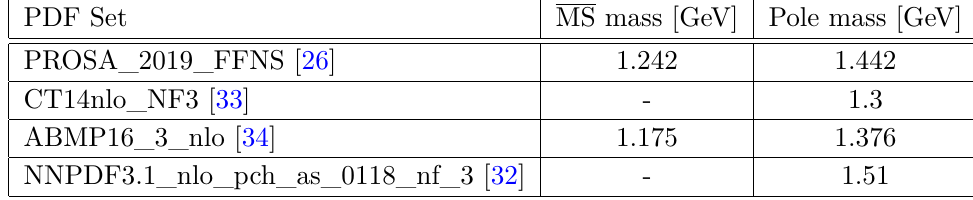
Table 1. The charm quark pole mass, and, if relevant, the MS mass for different PDF sets. Conversions from the MS to the on-shell renormalization scheme are performed at